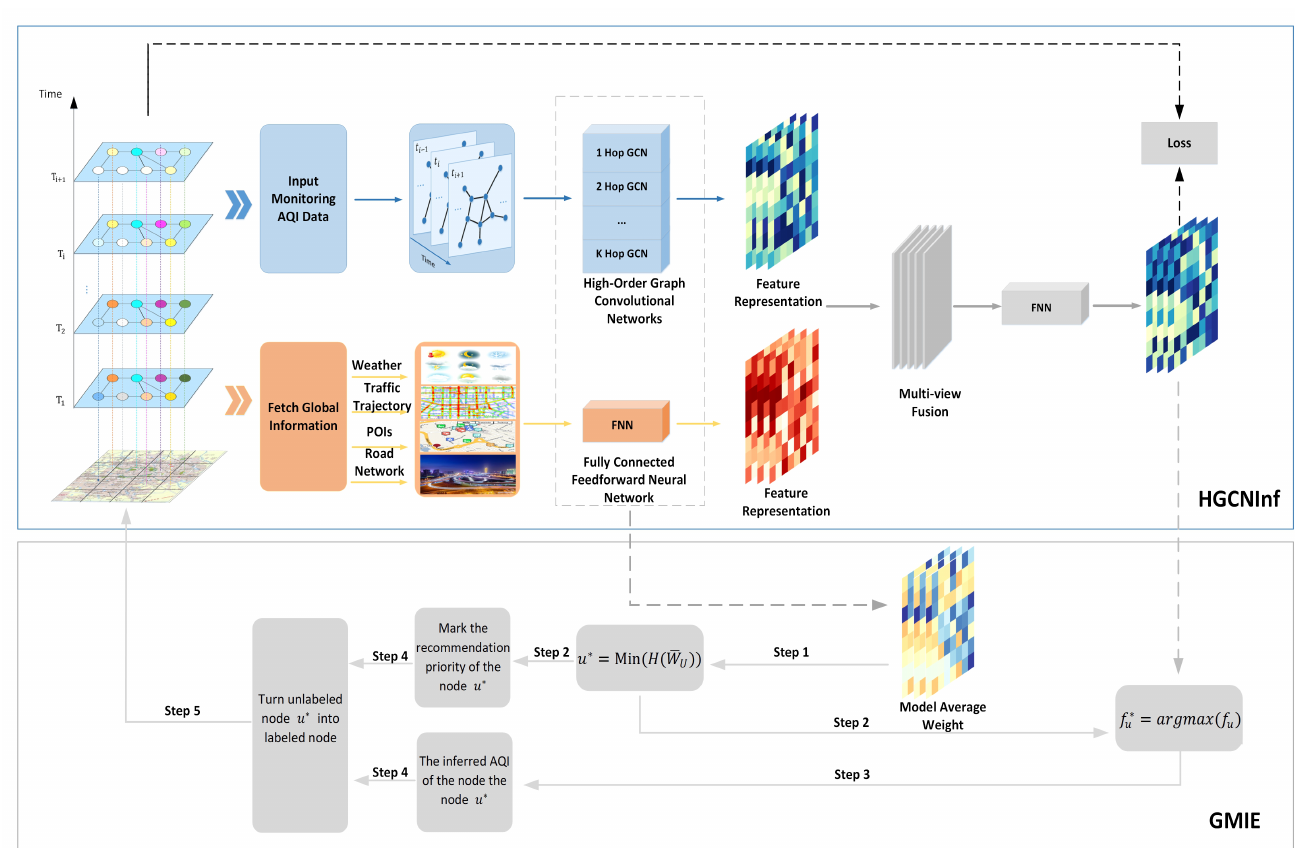
Figure 4. The general framework. (1) Air-quality-inference model: HGCNInf consists of a higher -order graph convolution network (HGCN) and several fully connected neural networks (FNN). By inputing historical monitoring data and by fetching global information, the HGCN is used to capture the spatiotemporal interactions of air-quality distribution and the FNN is used to extract the features of external factors. (2) Monitoring-station location recommendation model: by using the convolution weight parameters of HGCNInf, we designed a GMIE based on the correlation degree between nodes in USTG reflecting the air-quality spatiotemporal changes, marking the recommendation priorities of unlabeled nodes according to the ability to improve the inference accuracy of HGCNInf via the node incremental learning